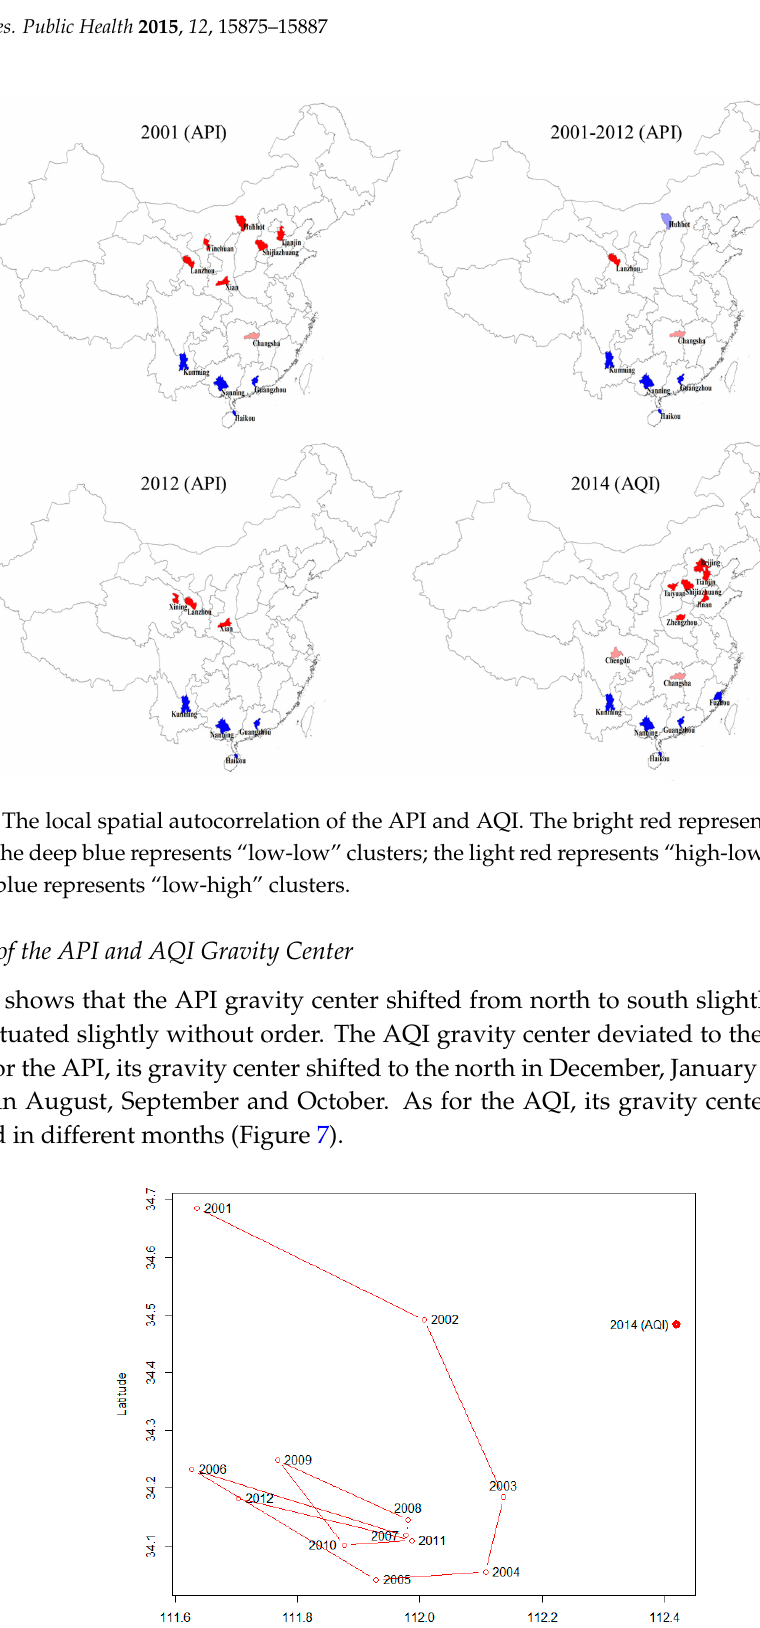
Figure 7. The shifts of the API and AQI gravity centers in different months.